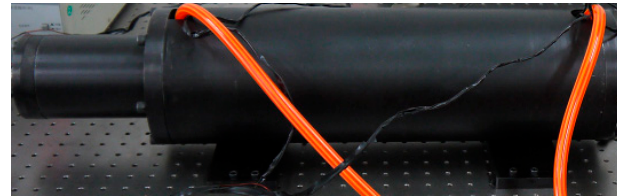
Figure 10. Experimental prototype of a giant magnetostrictive actuator.